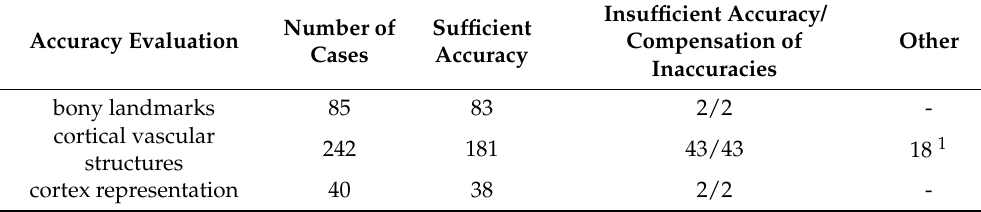
Table 1. Use of operating microscope and AR to verify and update navigation